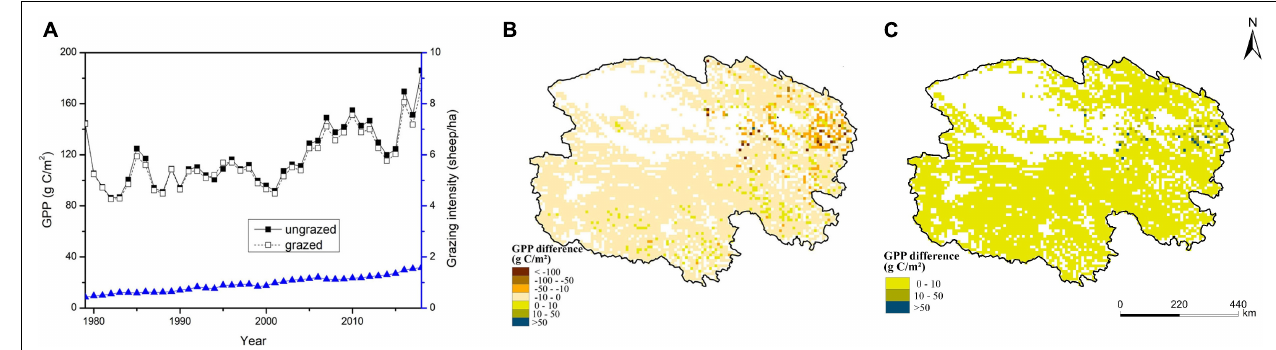
FIGURE 5 | Effect of grazing on the temporal (A) and spatial (B) dynamics of GPP and the map of the standard deviation of GPP difference (C) in Qinghai grasslands from 1979 to 2018 (GPP difference indicates the average annual difference between the grazed and ungrazed scenarios from 1979 to 2018).